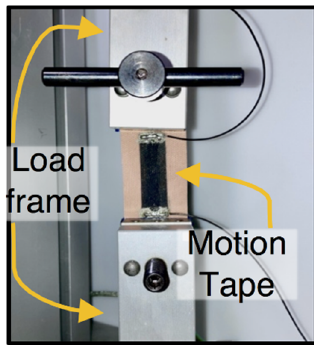
Figure 2. A Motion Tape specimen was mounted in a load frame for characterization tests.